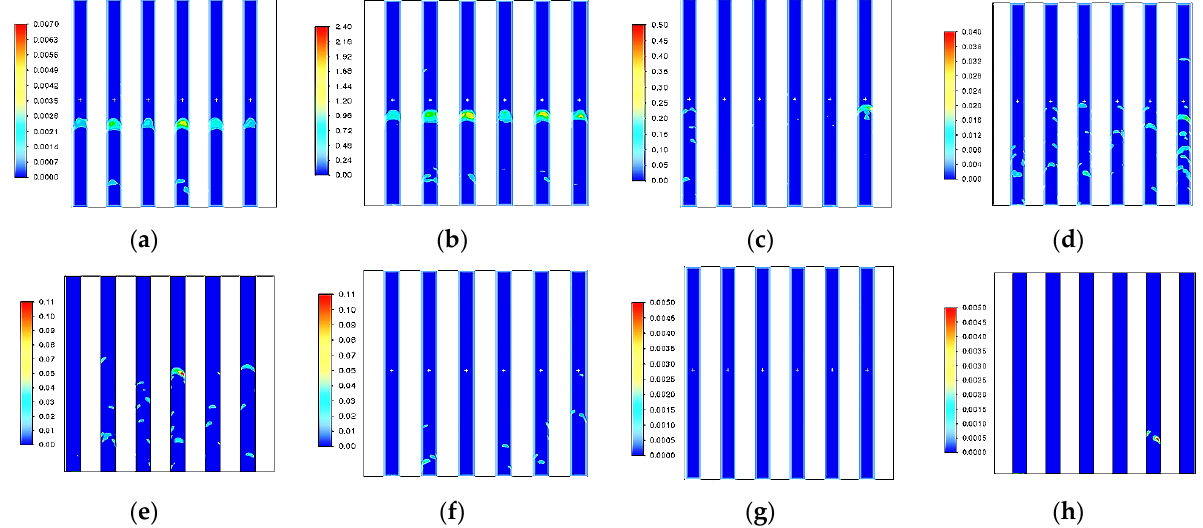
Figure 8. The regions of erosive wear rates W e , mm/year for different rows of elements in the separator with arc-shaped elements at particle diameter d p = 160 µm (frontal view, as seen from the inlet).